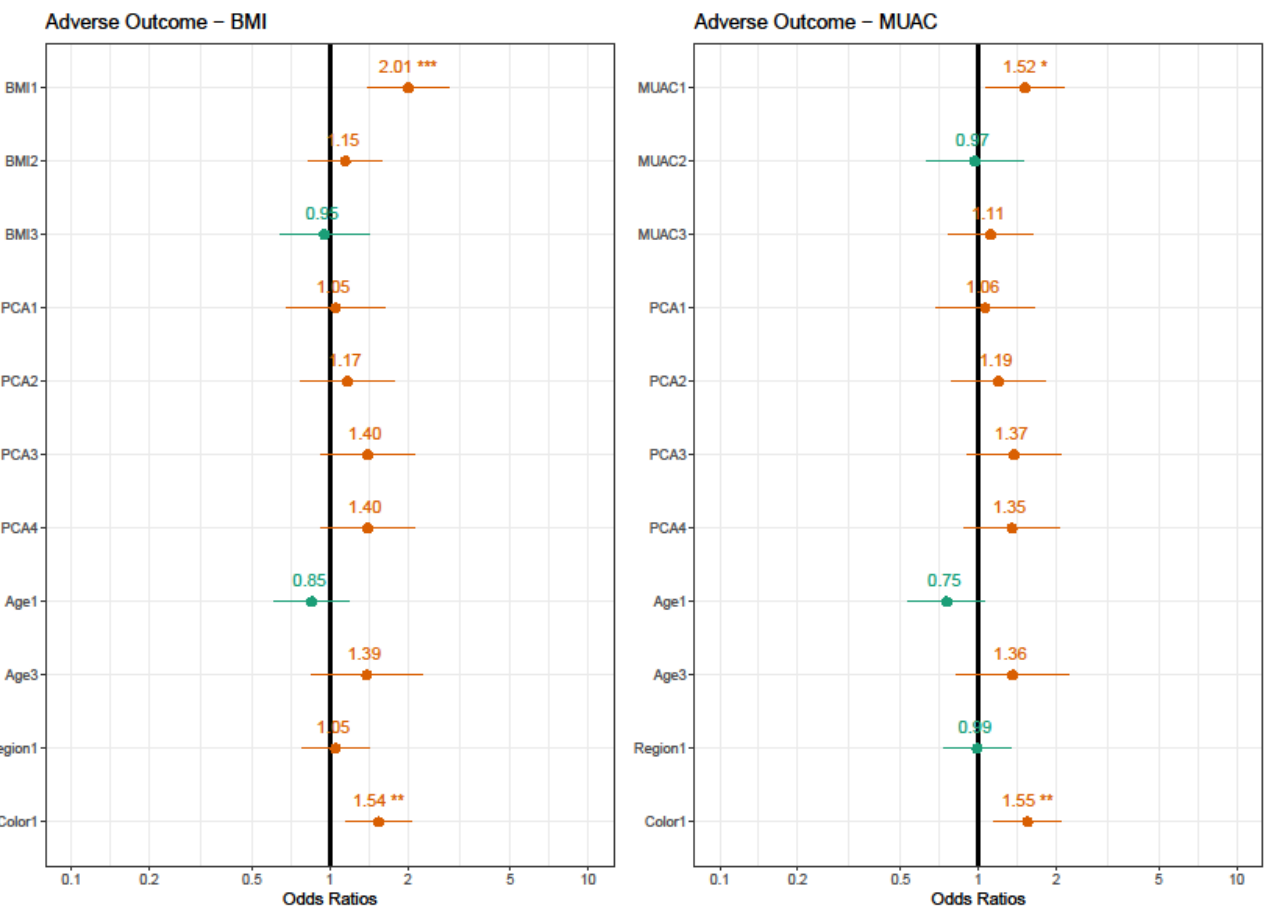
Figure 4. Estimated risks of adverse pregnancy outcome using BMI or MUAC. BMI 1: obese; BMI 2: overweight; BMI 4: underweight. MUAC 1: obese; MUAC 2: overweight; MUAC 4: underweight. Color 1: Non-white. AIC = BMI model: 1357.881/MUAC model: 1338.214. * Values of OR are significant at p < 0.05. ** Values of OR are significant at p < 0.01. *** Values of OR are significant at p < 0.001.